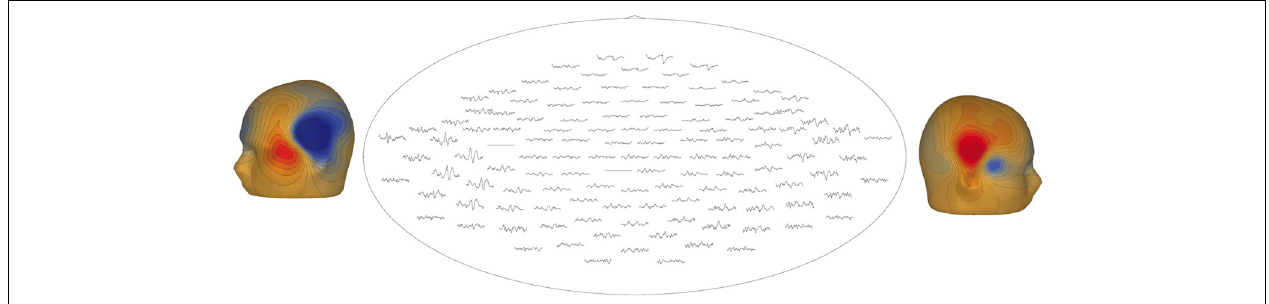
FIGURE 7 |Top-down view of MEG auditory evoked waveforms and left- and right-hemisphere “M50” magnetic field topographies for an 18-month-old participant (500 Hz tone). In the top-down view frontal sensors are shown at the top and occipital-parietal sensors at the bottom.